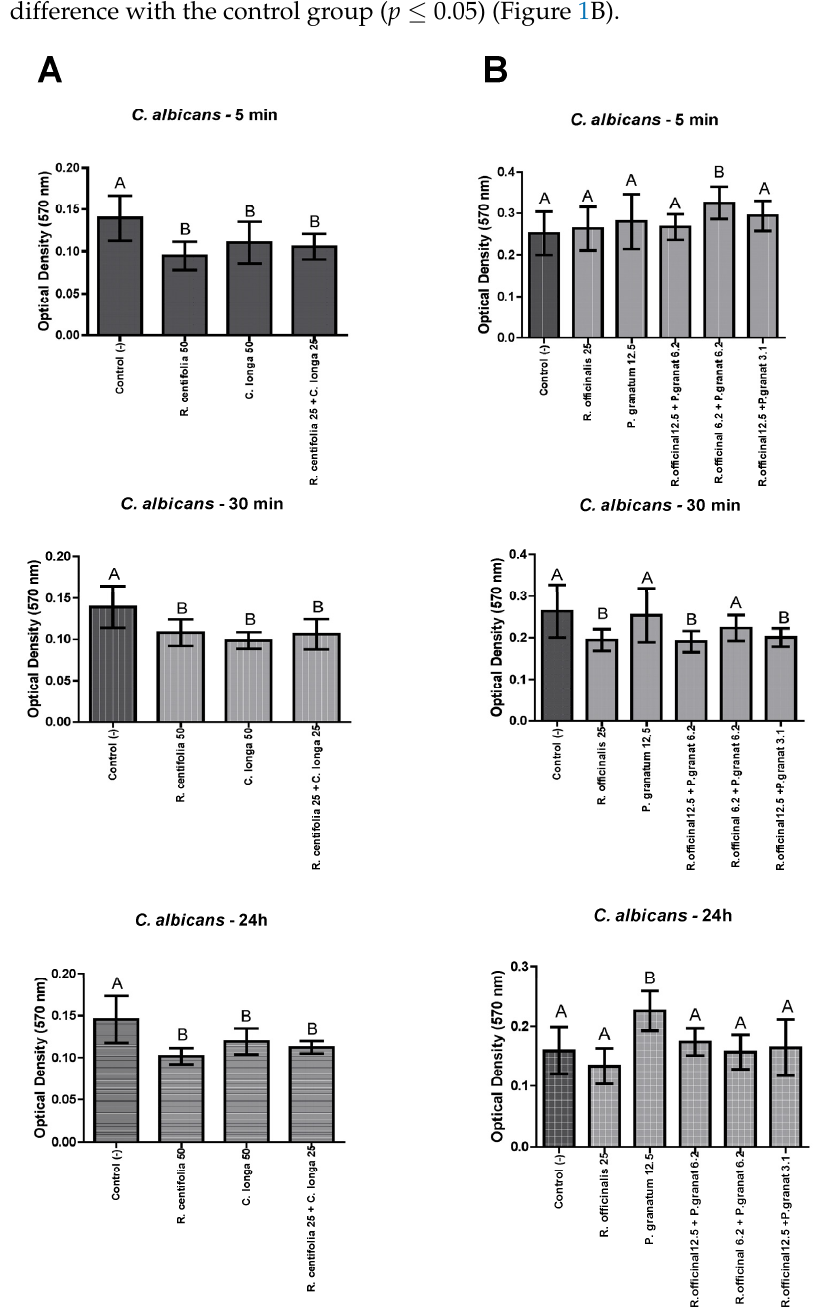
Figure 1. C. albicans biofilm load reduction after treatment with R. centifolia , C. longa , R. officinalis , and P. granatum glycolic extracts, and their combinations, for 5 min, 30 min, and 24 h. Legend: Different upper-case letters indicate a statistically significant difference.